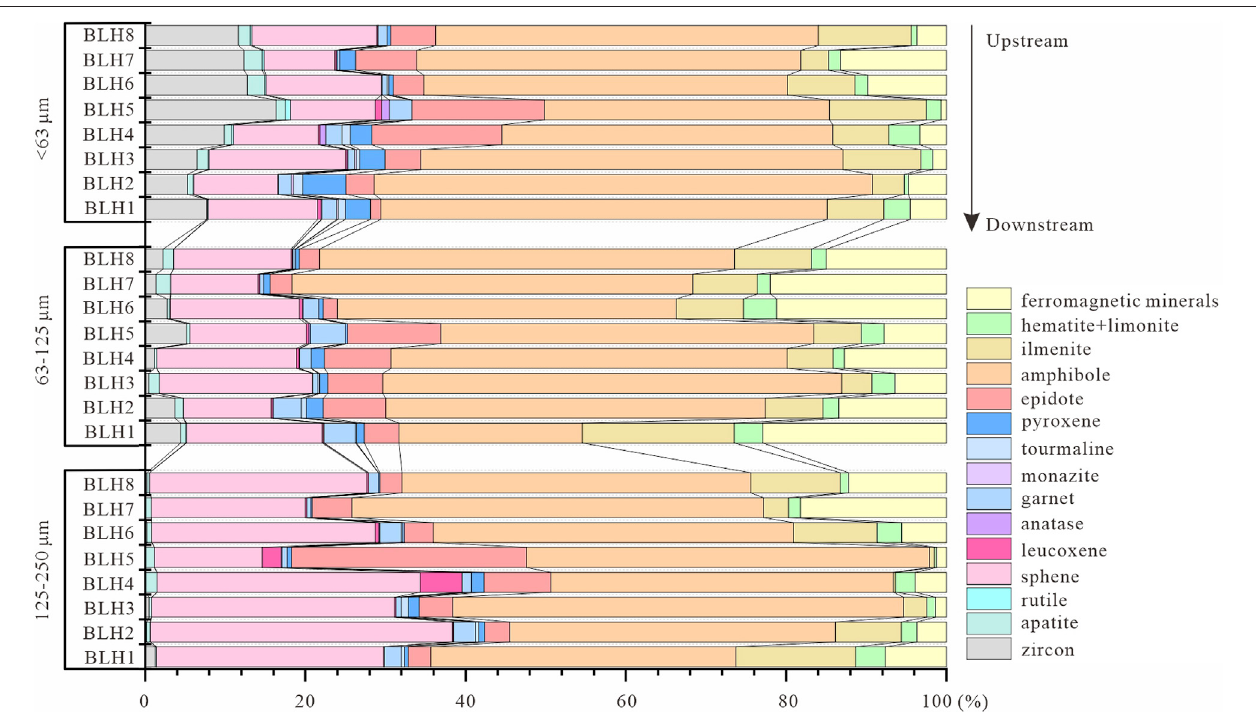
FIGURE 4 | Heavy mineral abundances (wt%) of three grain-size fractions in the Balan River from upstream to downstream. (For interpretation of the references to colour in this fi gure legend, the reader is referred to the web version of this article.)